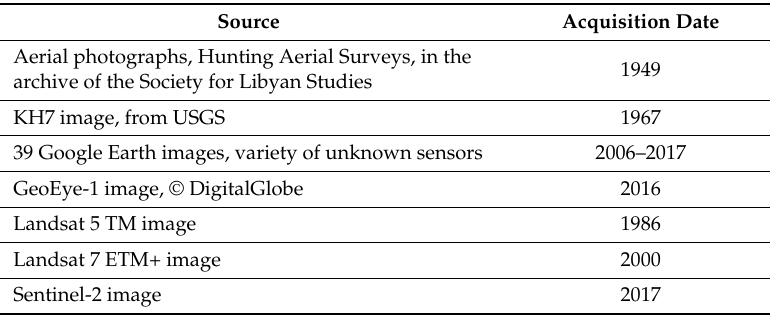
Table 5. Datasets used for recording